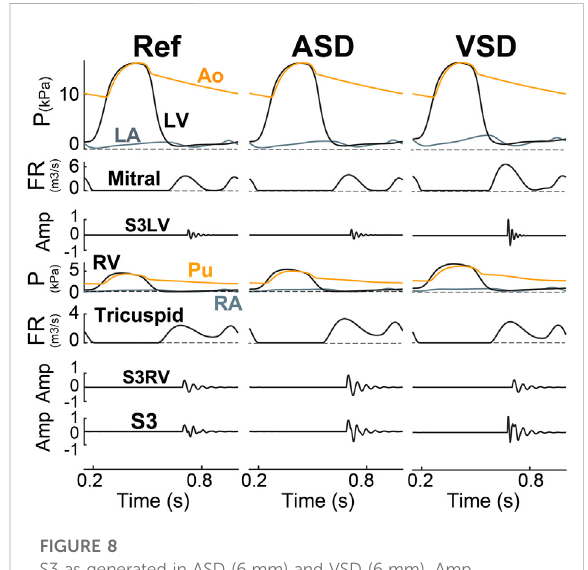
FIGURE 8 S3 as generated in ASD (6 mm) and VSD (6 mm). Amp, amplitude;Ao,aorta;ASD,atrialseptal defect;FR, fl owrate;LA,left atrium; LV, left ventricle; P, pressure; Pu, pulmonary artery; RA, right atrium; Ref, reference; RV, right ventricle; S3LV, left ventricular S3; S3RV, right ventricular S3; VSD, ventricular septal